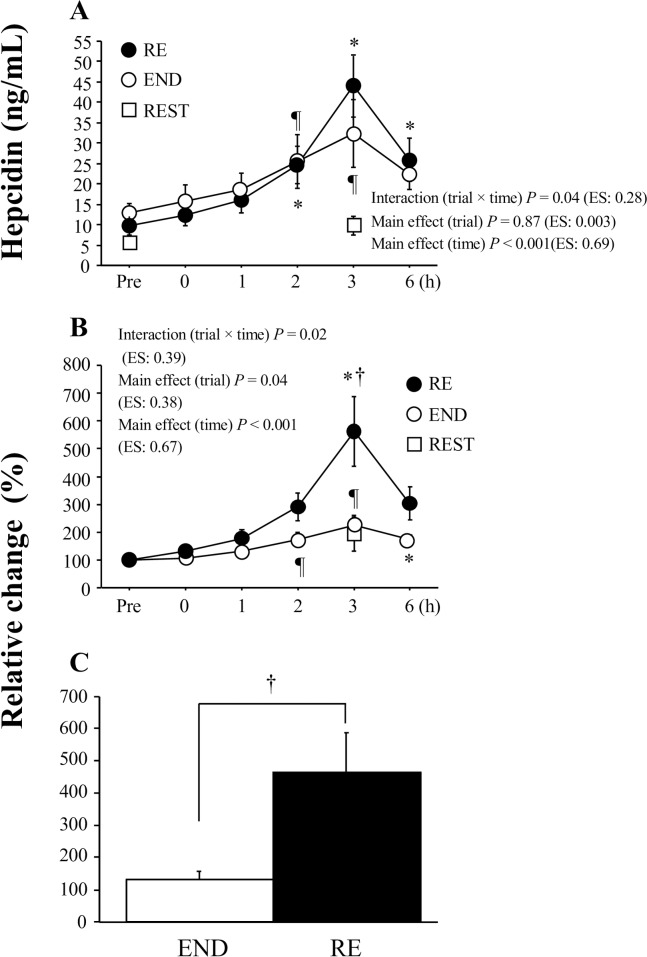
Plasma hepcidin levels before exercise and during the post-exercise period.Absolute levels (A) and relative values compared with the pre-exercise time point (B) are presented. (C) indicates relative change between pre-exercise levels and maximal levels during the post-exercise period in the RE and END. In the REST, plasma hepcidin levels were analyzed only before the start of the rest period and at a time point corresponding to 3 h after exercise in the RE and END. Values present means ± SE. *P < 0.05 vs. Pre (RE). ¶ P < 0.05 vs. Pre (END). †P < 0.05 between the RE and END.